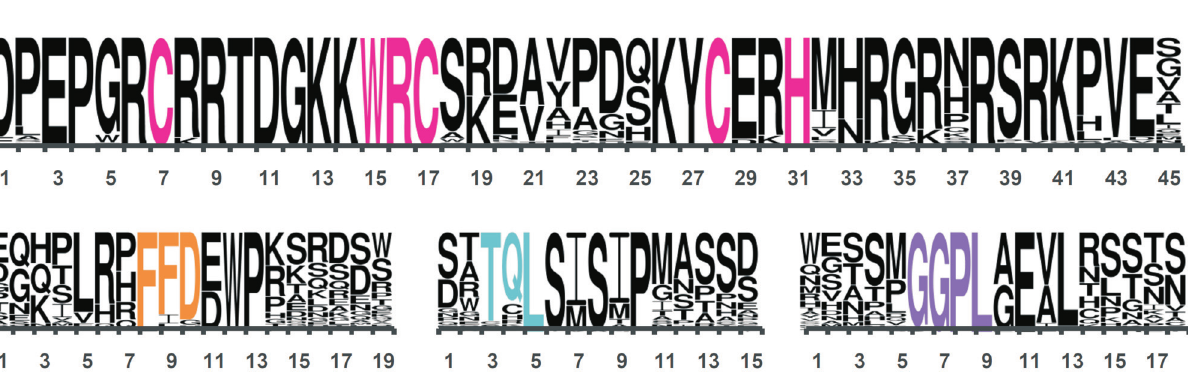
Figure 6 - Analysis of GRF motif conservation. Logos of QLQ (36 aa), WRC with the C3H motif (45 aa), FFD (19 aa), TQL (15 aa), and GGPL (18 aa) domains.Theheightofthelettersisbasedontheprobabilityoftheresidueintheposition,andthewidthwasadjustedtofit.Domaincolors:QLQingreen, WRC in pink, FFD in orange, TQL in blue, and GGPL in with domain distribution in all GRF proteins (Figure S1), and with gene structural organization (Figure 5) and synteny analysis (Figure 7A and 7B) from selected species.